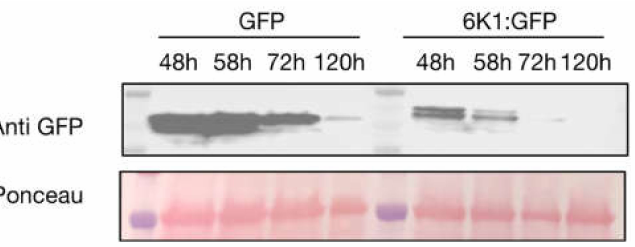
Figure 1. Ectopic expression of 6K1:GFP in Nicotiana benthamiana . The constructs GFP and 6K1:GFP were agroinfiltrated in N. benthamiana leaves. Western blots were performed with proteins extracted from the agroinfiltrated leaves collected over time. Anti-GFP antibodies were used in both western blots and Ponceau staining was performed to check for loading control. The top band in the 6K1:GFP blot represents 6K1 fused GFP. All western blots are representative of at least two replicates which each contained 3 plants per